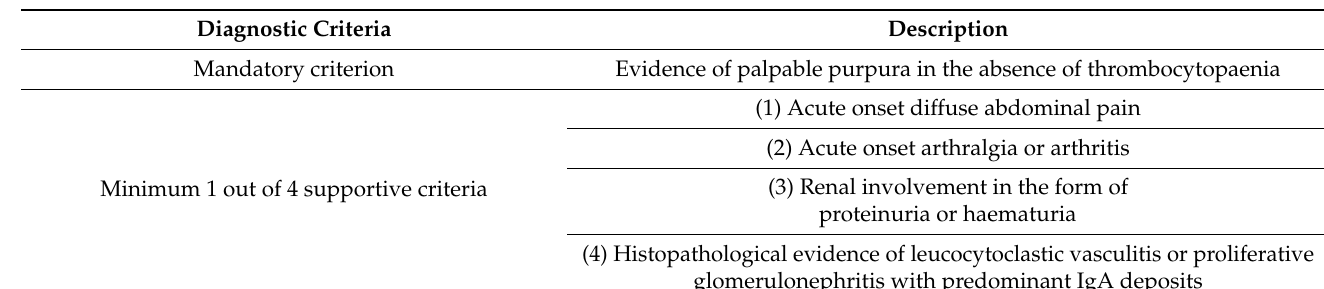
Table 1. European League Against Rheumatism, the Paediatric Rheumatology International Trials Organization and the Paediatric Rheumatology European Society (EULAR/PRINTO/PRES) 2008